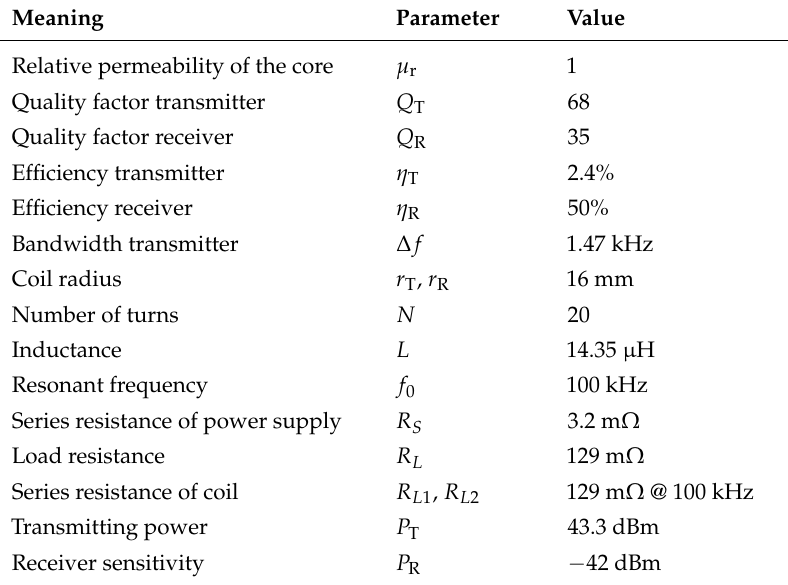
Table 2. Prototype system